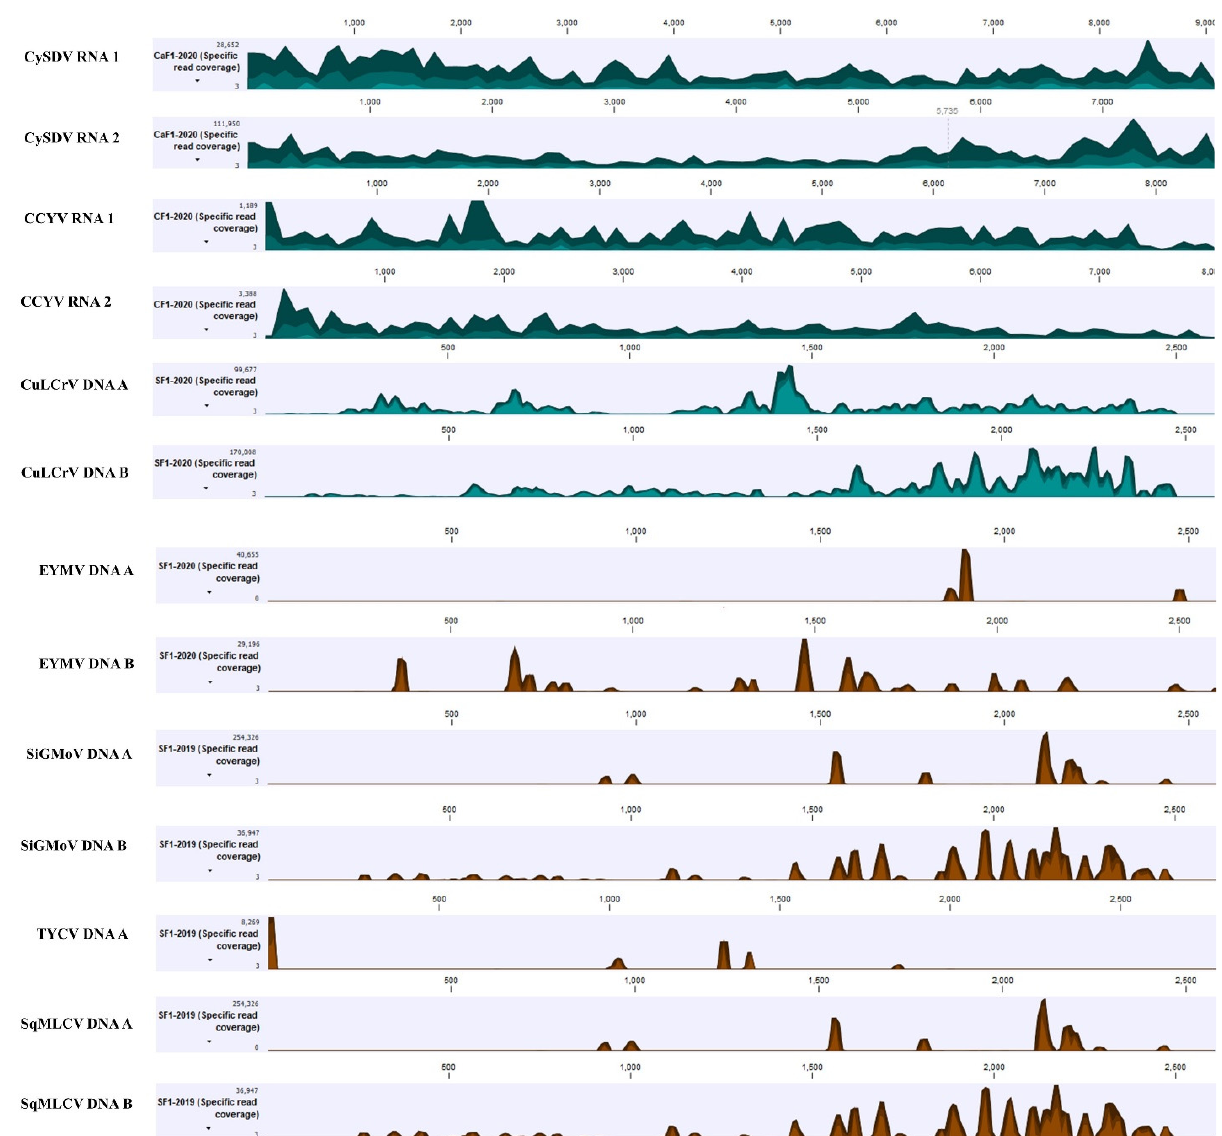
7 of 18 ( B ) Figure 2. ( A ) Viruses detected on cantaloupe (CaF1-2019, CaF1-2020, CaF2-2019), cucumber (CF1-2019, CF2-2019, CF1- 2020), and squash (SF1-2019, SF1-2020, SF2-2020) in Georgia by high throughput sequencing (HTS) of small RNAs ( A ) and